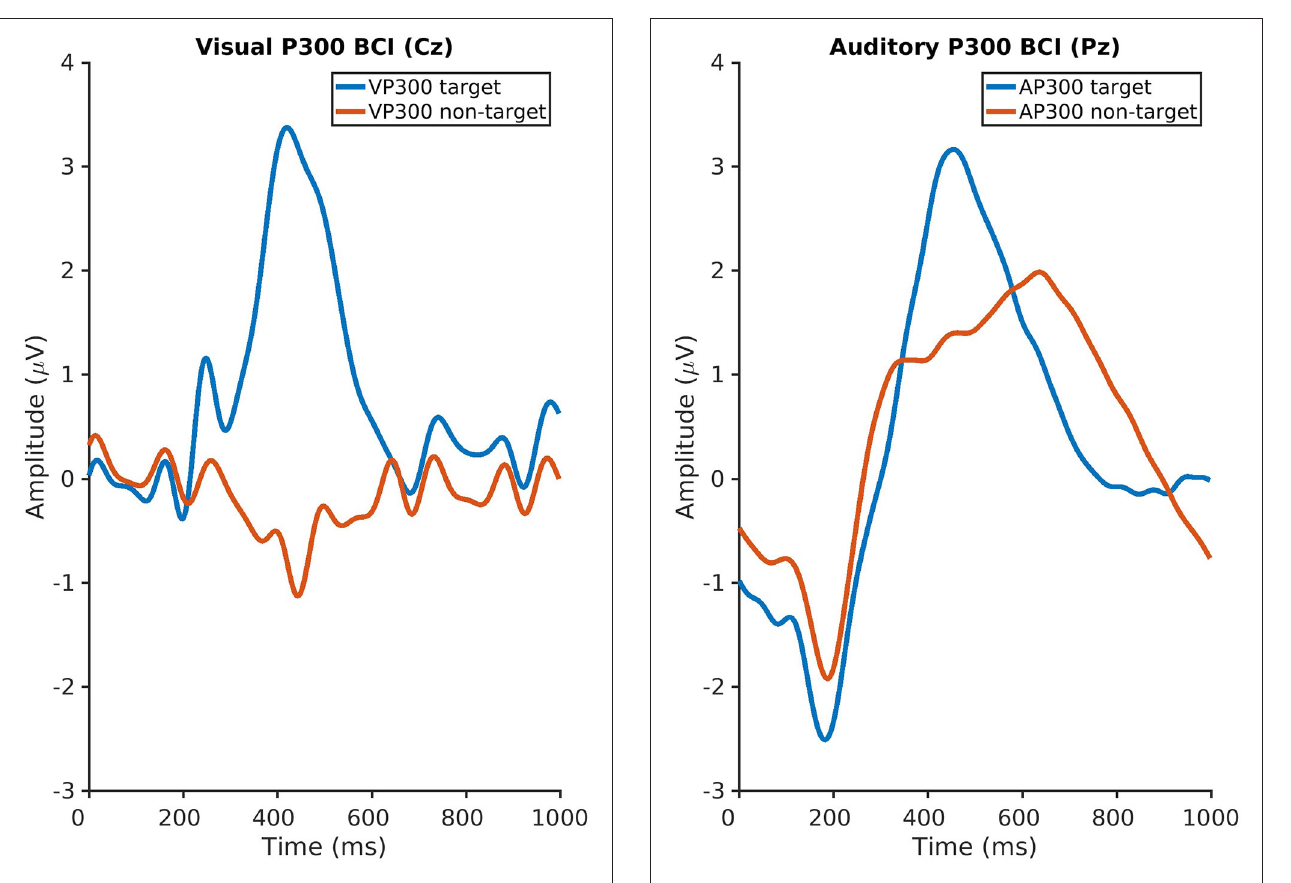
FIGURE 3 | Plot of the visual P300 at Cz averaged across all subjects. FIGURE 4 | Plot of the auditory P300 at Pz averaged across all